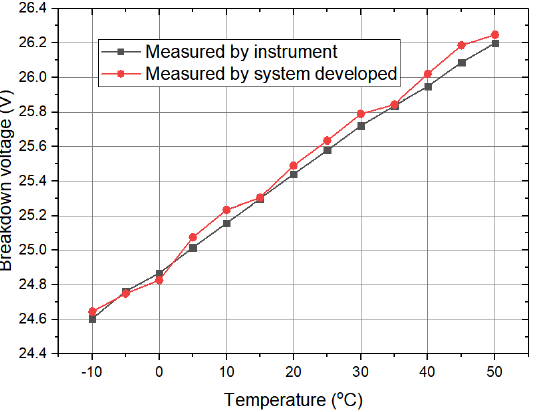
Figure 7. SPAD’s breakdown voltages measured for various temperatures by suing system developed and bench-top instruments.